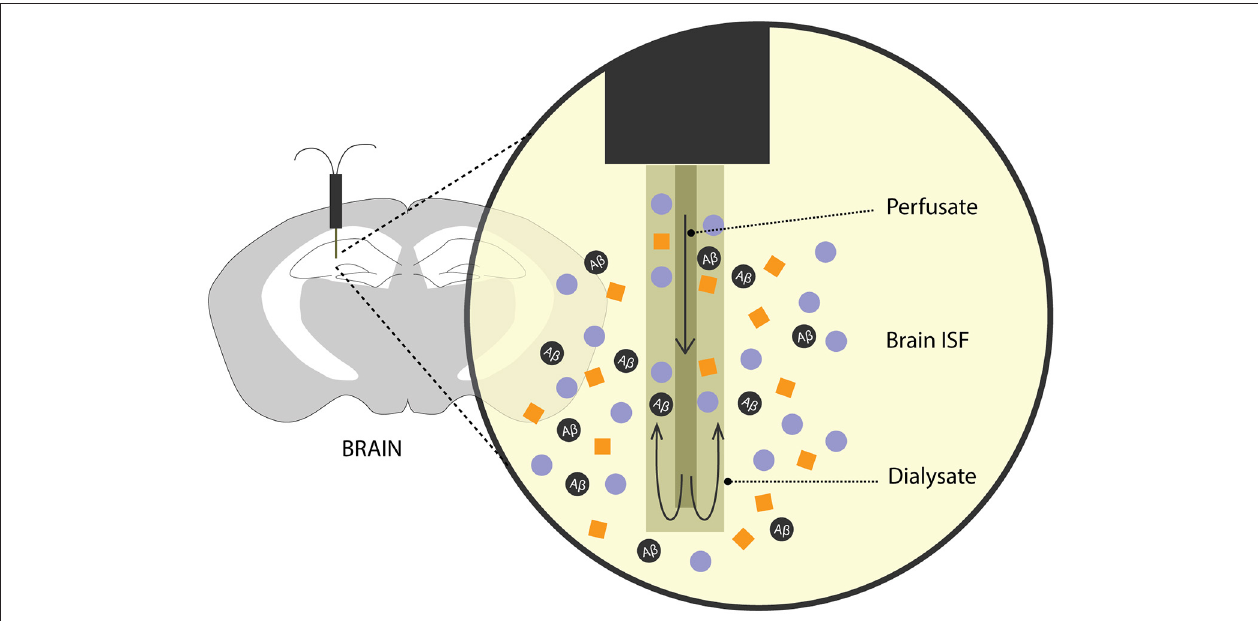
of microdialysates obtained over a period of time are then used to quantify A β levels reflecting steady-state levels and/or clearance of A β from the brain after inhibition of A β